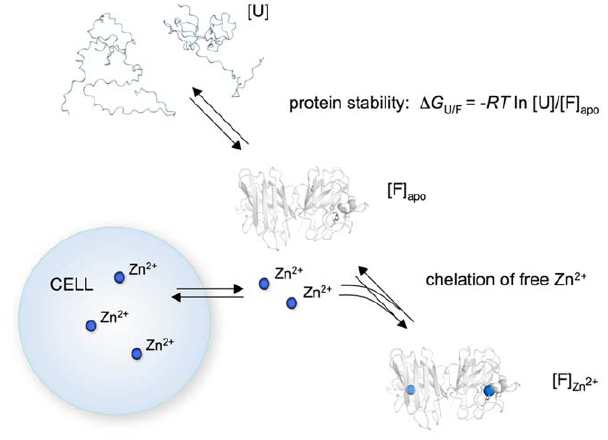
Figure 8. Schematic outline of how apoSOD1 exerts toxicity to cultured cells. Protein stability ( D G U/F ) determines the relative concentrations of unfolded ([U]) and folded ([F]) apo protein and, thus, the effective concentration of species able to chelate Zn 2 + from the growth medium. For stable mutations where [F] apo & [U], the protein acts as an efficient Zn 2 + chelator, disturbing the cellular Zn 2 + homeostasis. In the most simplistic case, the apoSOD1 molecules do not interact with the cells but lower the intracellular Zn 2 + levels by preventing reflux from the growth medium.